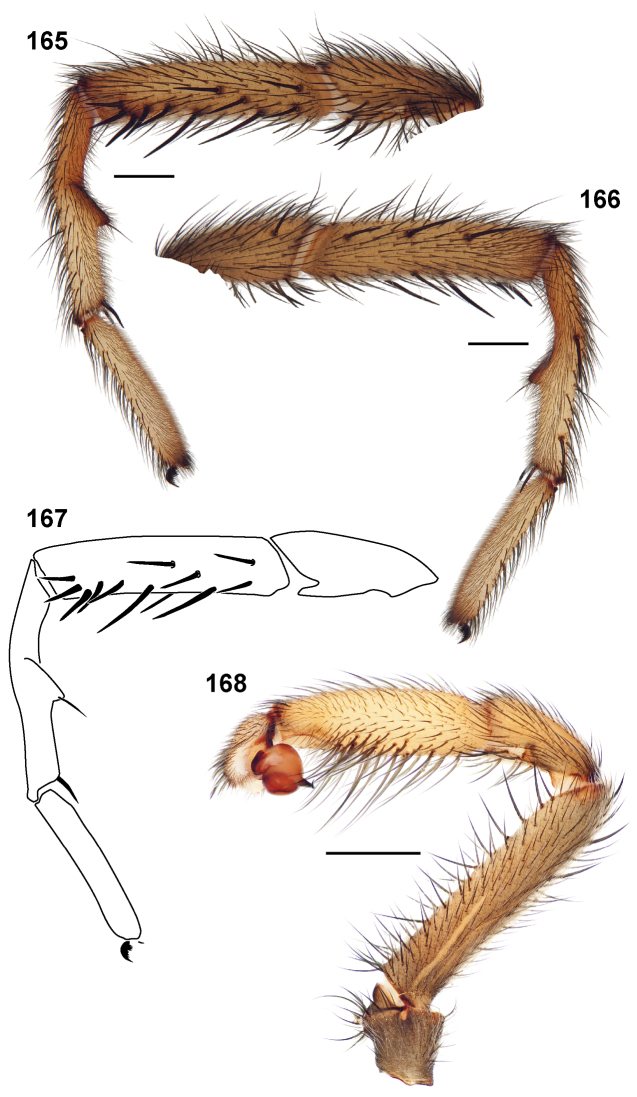
Aptostichus isabella sp. n. male holotype (MY3824) from Kern Co. 165–167 leg I 165 retrolateral aspect [805901] 166 prolateral aspect [806607] 167 line drawing, retrolateral aspect 168 retrolateral aspect, pedipalp [805903]. Scale bars = 1.0mm.